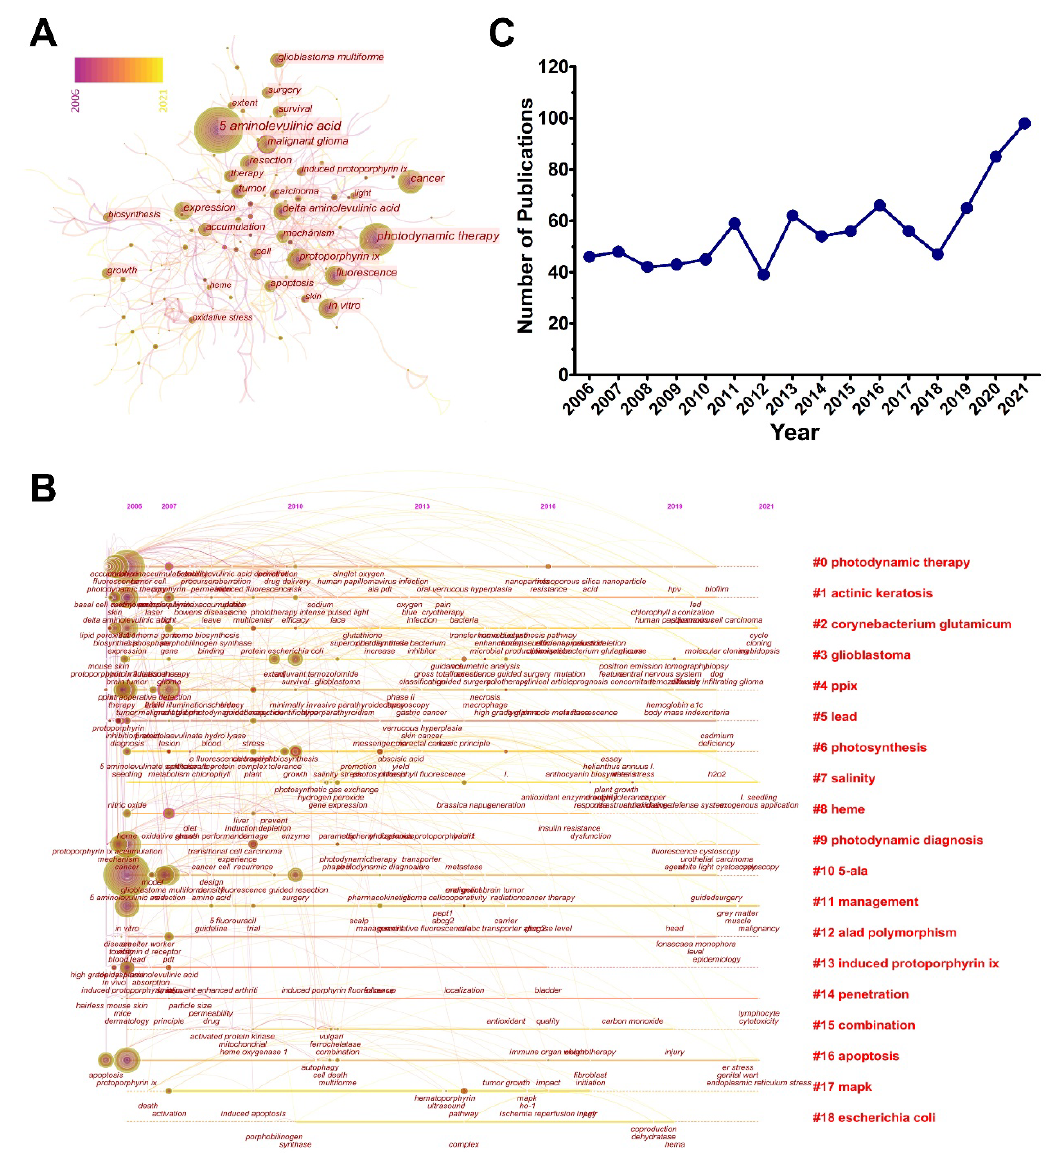
Figure 4. Research topics of 5-ALA research related photodiagnosis/photodynamic therapy. ( A ) Co-occurrence network of keywords in this field analyzed by CiteSpace. ( B ) Major research topics clustered by CiteSpace. ( C ) The annual changes of 5-ALA based photodiagnosis/photodynamic therapy publication. Data were achieved in the retrieve formula of TI = (*aminolevulinic acid OR 5-ALA) AND TS = (photodiagnosis OR photodynamic) and articles